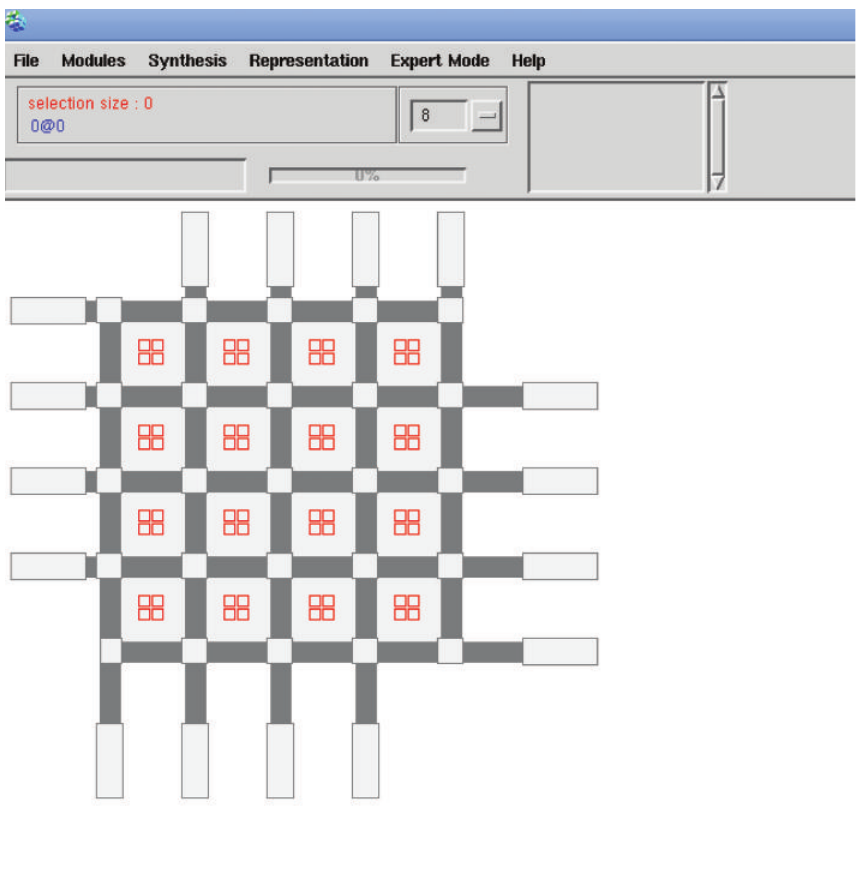
Figure 5: Whole view of the